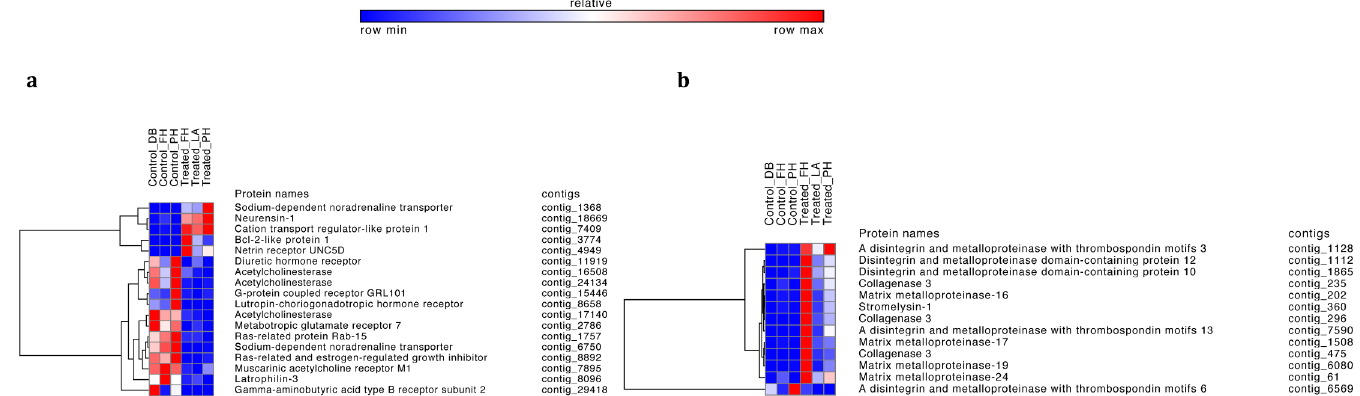
Fig 4. Neural and tissue remodeling pathway heatmaps. Heatmaps of (a) neural and (b) tissue remodeling differentially expressed transcripts between control and treated sea stars.